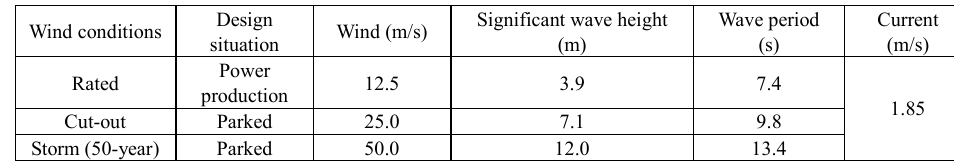
Table 1. Wind turbine and metocean conditions.